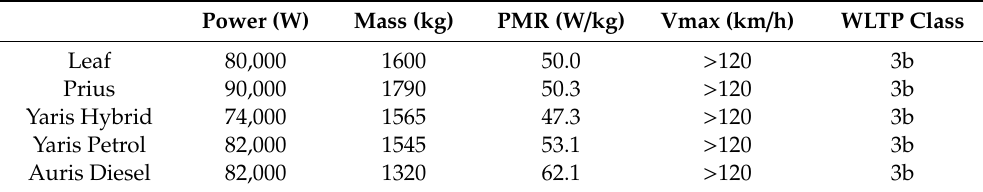
Table 7. Class in WLTP classification of vehicle